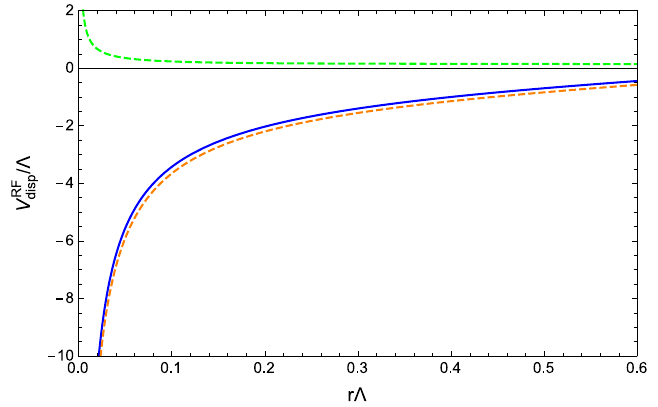
Figure 10 . V RF = (cid:3) as a function of r (cid:3) . The red dashed line and green bashed line, re- disp MS MS spectively, are the parts extracted from the ambiguity functions corresponding to the u = 1 = 2 and u = 3 = 2 renormalons. The blue line is the sum of them.